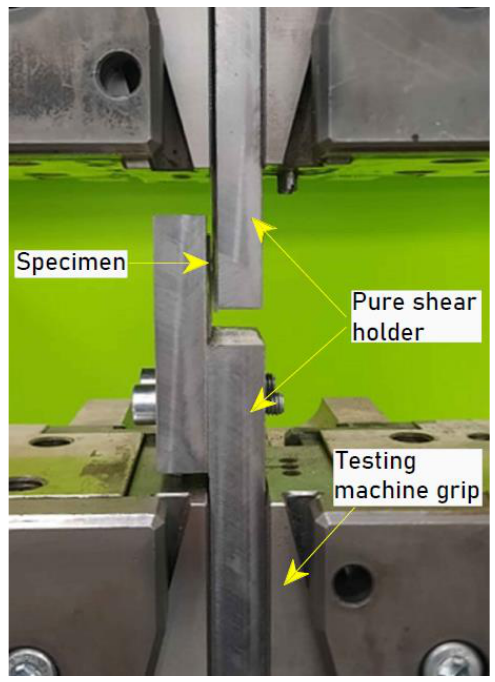
Figure 4. Configuration of the pure shear holder in the grippers of the tensile testing machine.